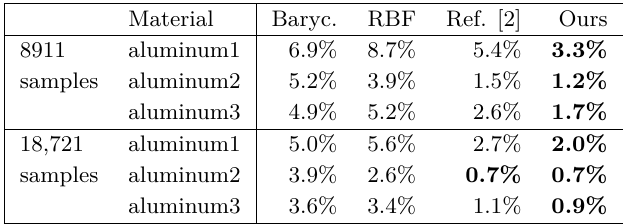
Fig. 13 Percentage MRE for the proposed method and the method in Ref. [2] for two numbers of samples (schemes 14 and 19).